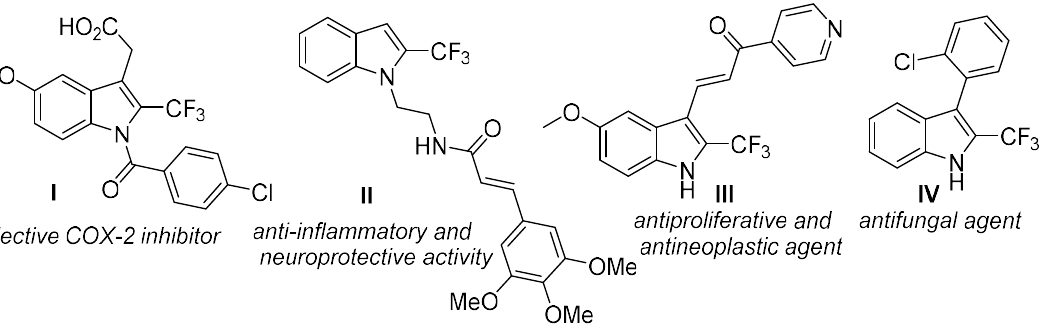
Figure 1. Representative 2-CF 3 -indoles having biological activity.